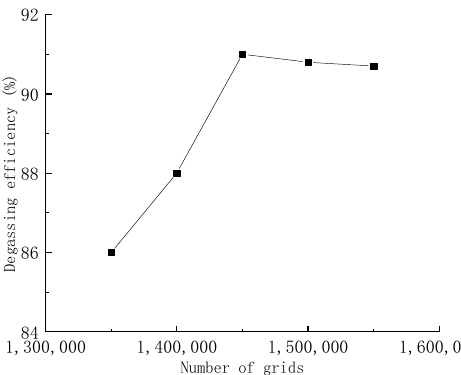
Figure 2. Grid independence test graph.